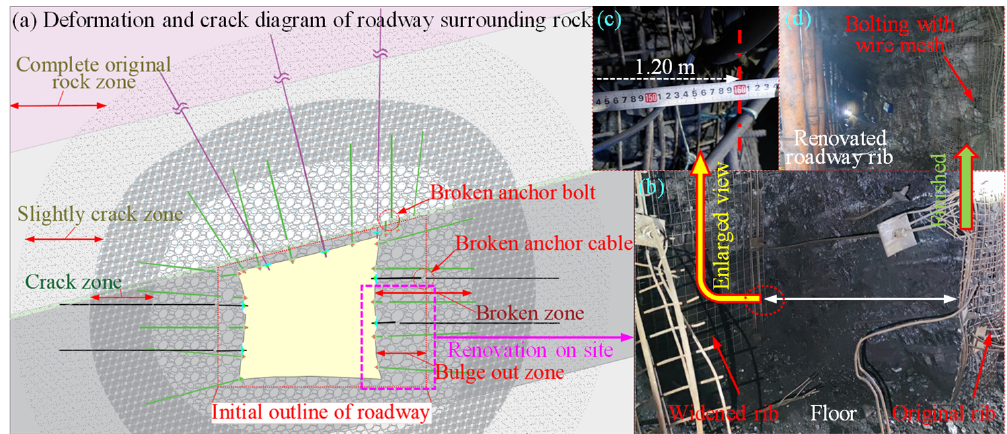
Figure 2. Location of panel 11231 and the columnar section of the coal and rock strata. ( a ) Location of panel 11231; ( b ) Columnar section of the coal and rock strata.